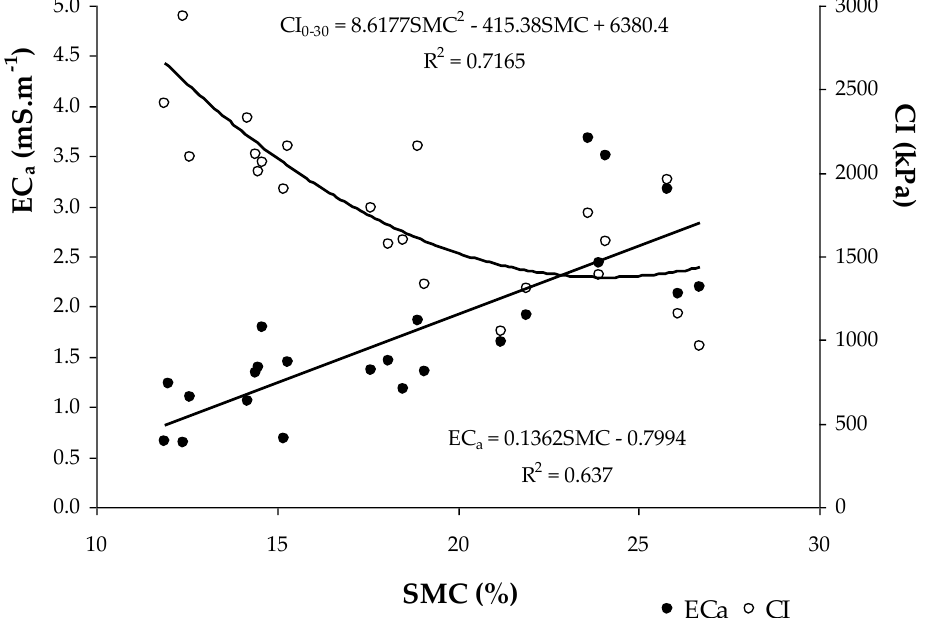
Figure 9. Relationship between soil moisture content (SMC) and soil apparent electrical conductivity (EC a ) and the Cone Index (CI) in the 0 – 0.30 m soil layer (2018).